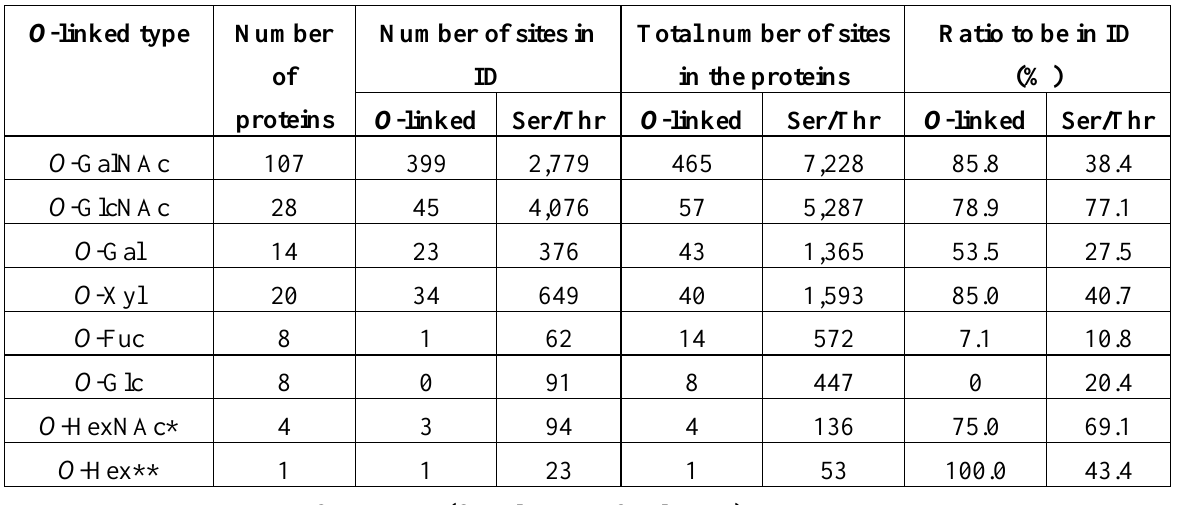
Table 2. Frequencies of occurrence of the mucin type and non-mucin-type O -glycosylations at residue sites in ID regions. The total numbers of Ser and Thr residues are also shown for reference. 190 proteins were taken from UniProt 14.0, and ID regions were obtained from DICHOT